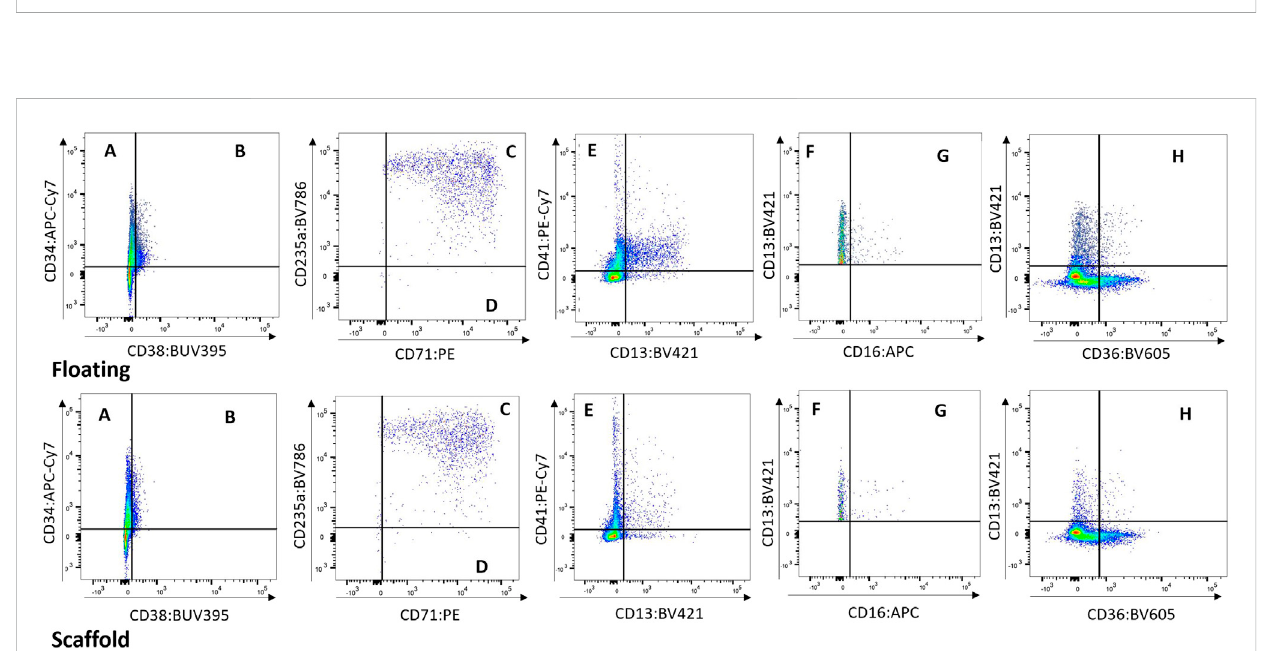
FIGURE 4 Floating vs. Scaffold Comparison. Example of Floating versus Scaffold gating for a control group circuit at Day 14 (study BM-1). (A) contains CD38 − CD34 + cells, called Long term HSCs; (B) contains CD38 + CD34 + cells, called Lineage Differentiated Progenitors; (C) contains CD13 − CD36 + CD71 + CD235a + cells, called Late Erythroid cells; (D) contains CD13 − CD36 + CD71 + CD235a − cells, called Early Erythroid cells; (E) contains CD13 − CD41a + cells, called Platelets; (F) contains CD16 − CD13 + cells, called Early Myeloid; (G) contains CD16 + CD13 + cells, called Late Granulocytes; (H) contains CD13 + CD36 + cells, called Late